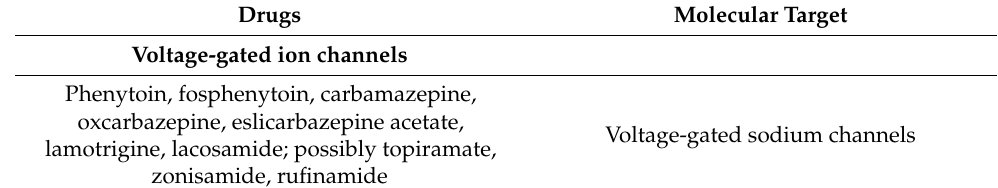
Table 1. Common Drugs and their Molecular